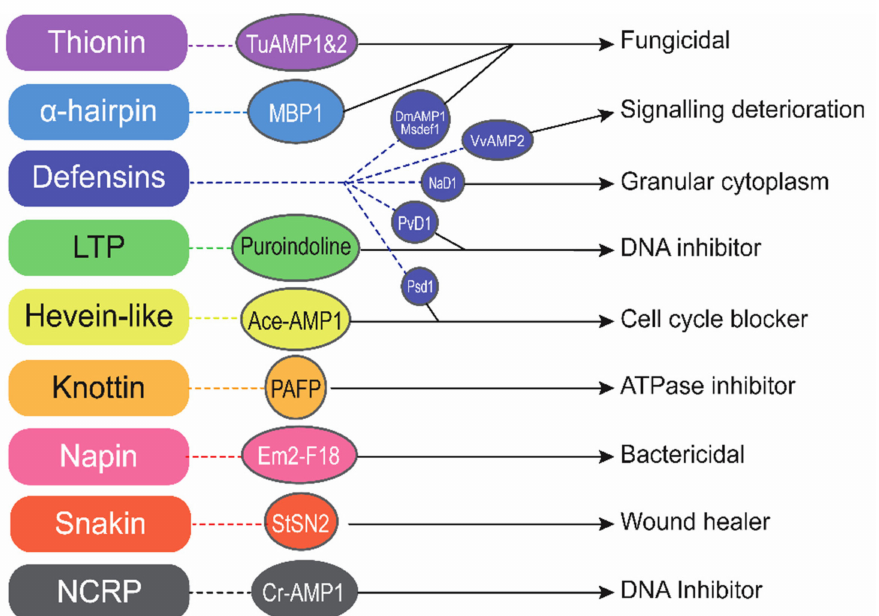
Figure 5. Cellular targets and the associated role of different plant-derived AMPs. Herein, different classes of AMPs (left) are connected with representative examples by dotted colored lines. Functions of the AMPs (right) are connected with the cellular targets by solid black lines. Abbreviations: lipid transfer proteins, LTP; non-cysteine-rich-peptides, NCRP; antimicrobial peptide 1 & 2 of Tulipa gesneriana ,TuAMP1&2; myelin basic protein 1, MBP1; antimicrobial peptide 1 from Allium cepa , Ace-AMP1; anti-fungal protein of Phytolacca Americana , PAFP; peptide from Eugenia malaccensis , Em2-F18; snakin-2 from Solanum tuberosum , stSN2; cathelin-related antimicrobial peptide, cr-AMP1; antimicrobial peptide 1 of Dahlia merckii , DmAMP1; antimicrobial peptide 2 of Vitis vinifera , VvAMP2; Nicotiana alata defensin 1, NaD1; Phaseolus vulgaris defensin 1, PvD1; Pisum sativum defensin 1,